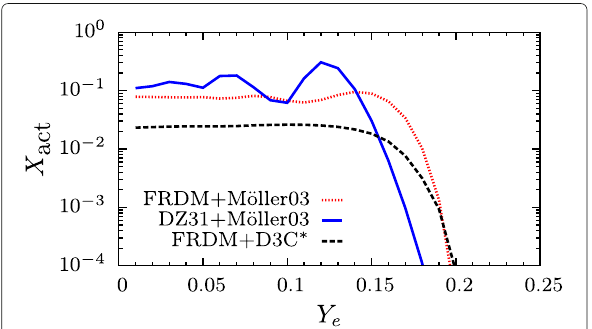
Fig. 1 The actinide mass fraction X act as a function of Y e for a trajectory with an initial entropy per nucleon s = 10 k B and a dynamical timescale τ = 10 ms. The red dotted, blue solid, and black dashed lines are obtained with different combinations of theoretical nuclear mass models (FRDM or DZ31) and (“+”) β -decay rates (Möller03 or D3C ∗